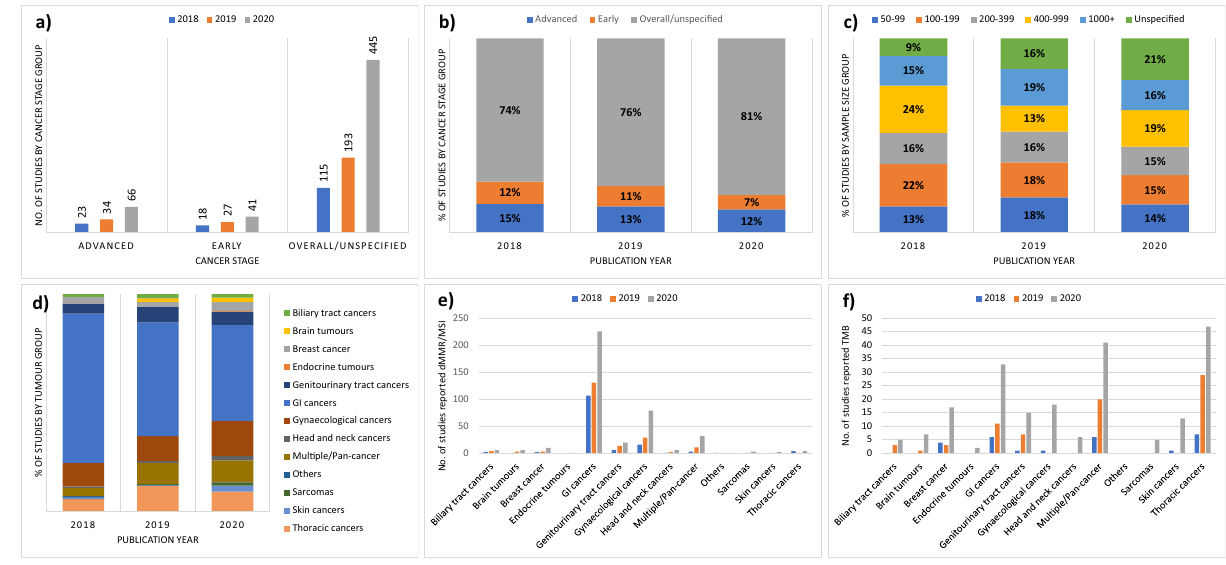
Figure 2. Landscape of studies reporting the prevalence of dMMR/MSI/high TMB. ( a ) Number of studies by cancer stage; ( b ) the relative proportion of studies by cancer stage; ( c ) the relative proportion of studies by study sample size; ( d ) the relative proportion of studies by tumour group; ( e ) number of studies reporting the prevalence of dMMR/MSI; and ( f ) number of studies reporting the prevalence of high TMB. dMMR mismatch repair deficiency; MSI microsatellite instability; TMB tumour mutational burden.